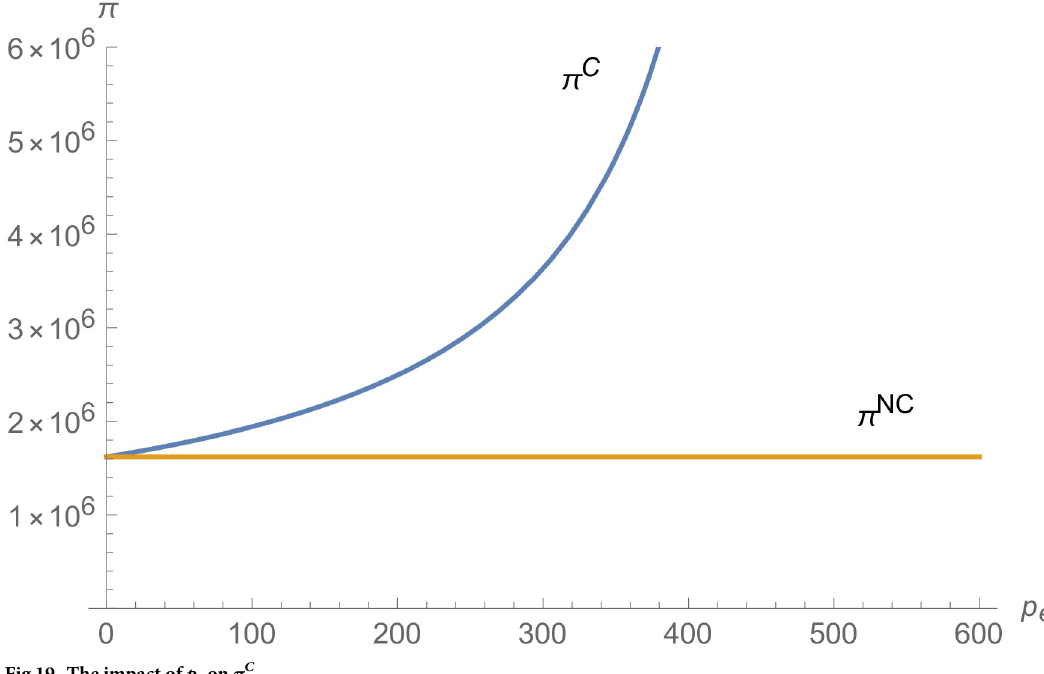
Fig 19. The impact of p e on π C .